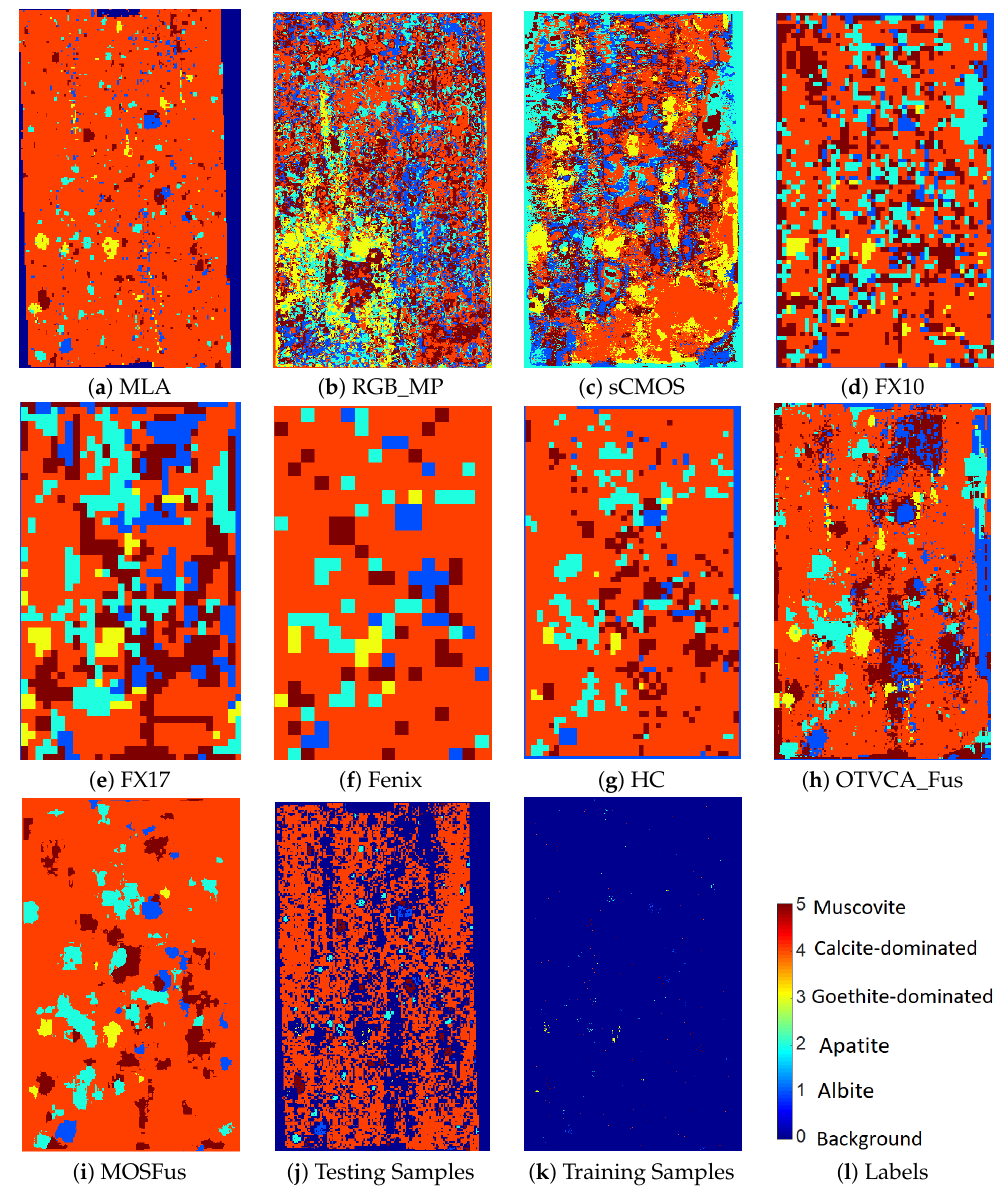
Figure 6. The classification maps of different fusion techniques and different sensors using SVM applied on the RZ2